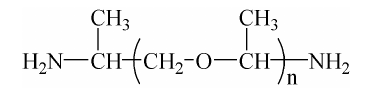
Figure 13. The molecular formula of polyoxide propylene diamine.